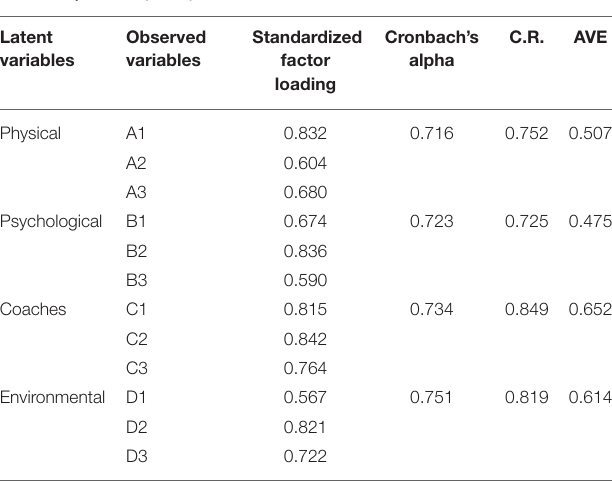
TABLE 3 | Reliability